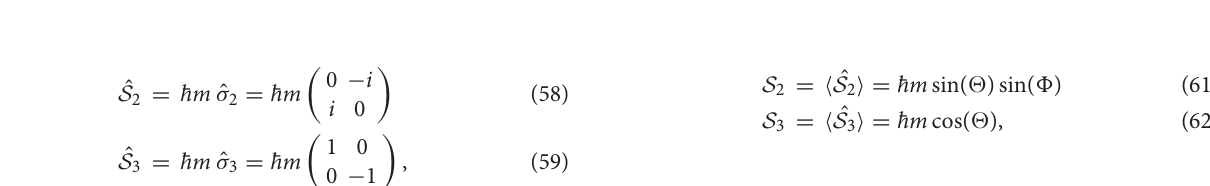
FIGURE 15 | Hyper-Poincaré sphere for describing a quantum state of a vortex. The polar angle of 2 will control the amplitudes of the left and the right vortexed states, while the azimuthal angle of 8 will control the phase between these basis states. Insets show examples of various vortexed states simulated in this